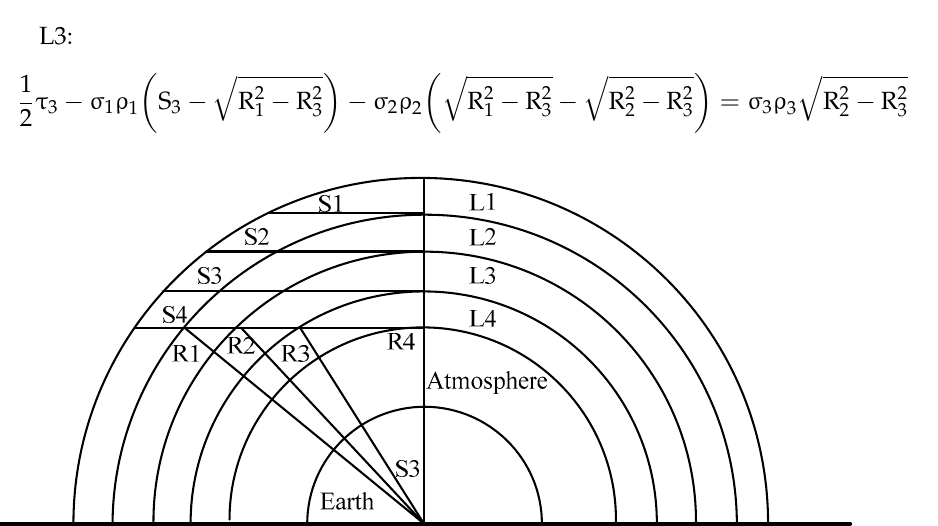
Figure 2. The principal diagram of the stratification of the earth’s atmosphere, as well as the inversion. The number of observations is equal to the number of layers in the atmosphere.